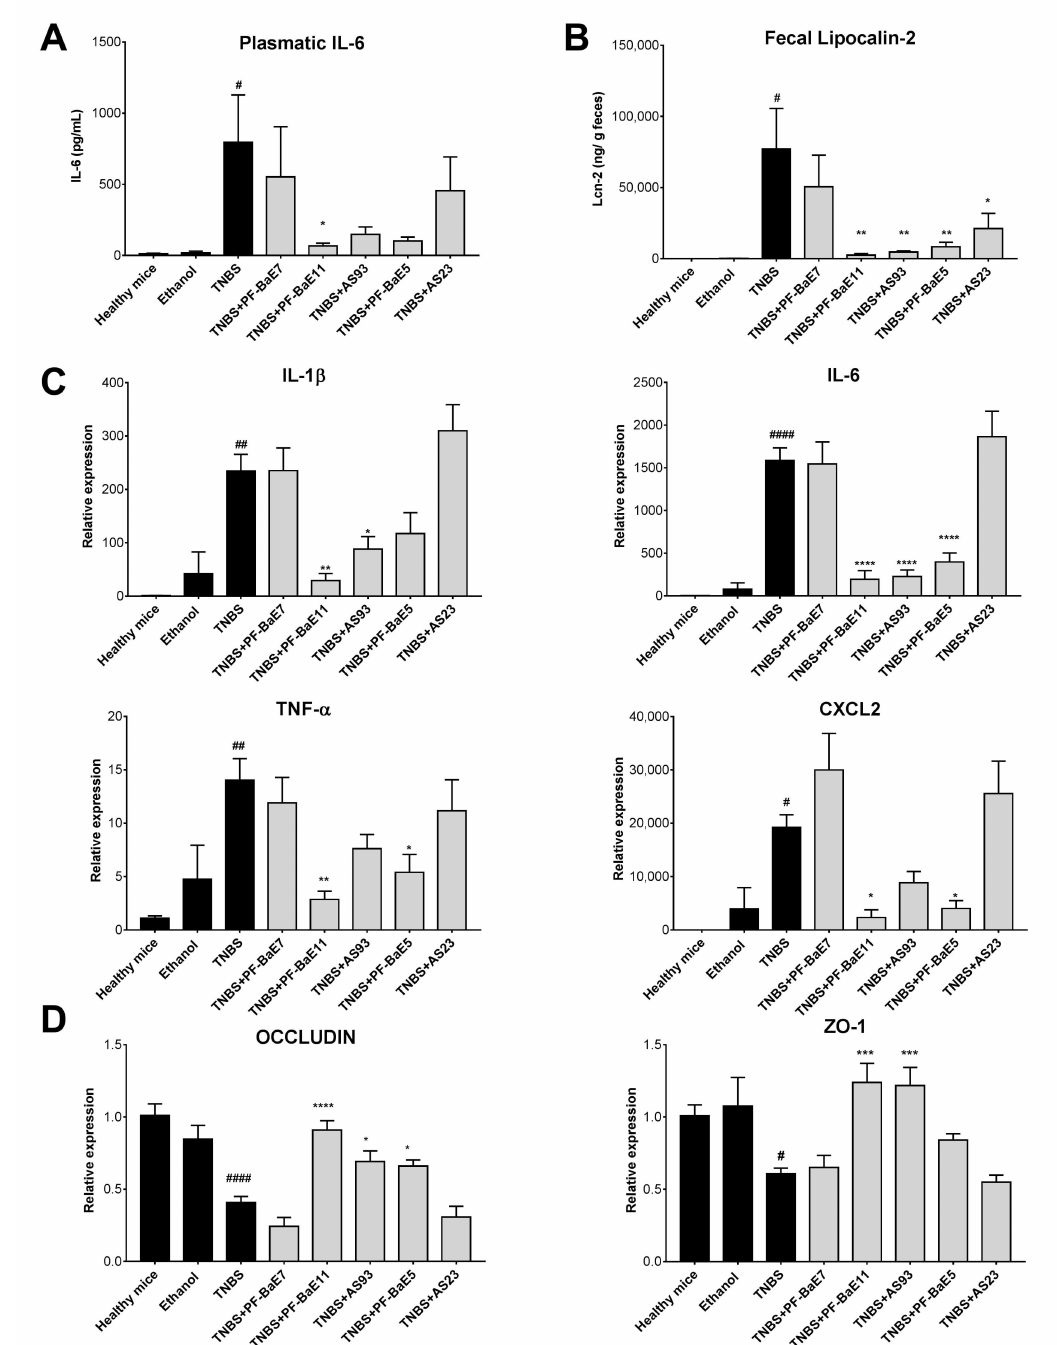
Figure 5. Capacity of the strains to modulate ( A ) the plasmatic IL-6 concentration (pg / mL), ( B ) the fecal lipocalin-2 levels ( µ g / g feces), ( C ) the expression of genes encoding proinflammatory markers or ( D ) tight junction proteins during TNBS-induced colitis. IL-6 and fecal lipocalin-2 concentrations were measured by ELISA. Gene expression of Il1b, Il6, Tnfa , Cxcl2, Occludin and Zo1 was evaluated by qRT-PCR from colonic samples obtained two days after colitis induction. Results are expressed as Relative expression compared with values obtained from healthy mice. Data represent means of each group ( n = 9 mice per group) ± SEM. # and * refer to the comparisons of the TNBS-treated control versus healthy mice or bacteria-treated group versus TNBS control group, respectively; # or * p < 0.05, ## or ** p < 0.01, *** p < 0.001, #### or **** p <